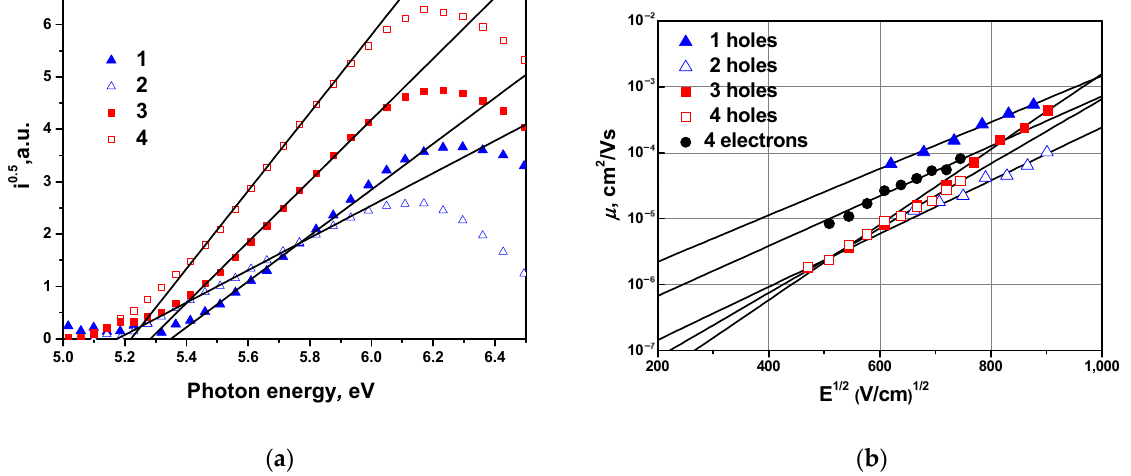
Figure 4. ( a ) Photoelectron emission spectra of the layers of compounds 1 – 4 ; ( b ) electric field dependence of hole and electron mobilities for the layers of compounds 1 – 4 .